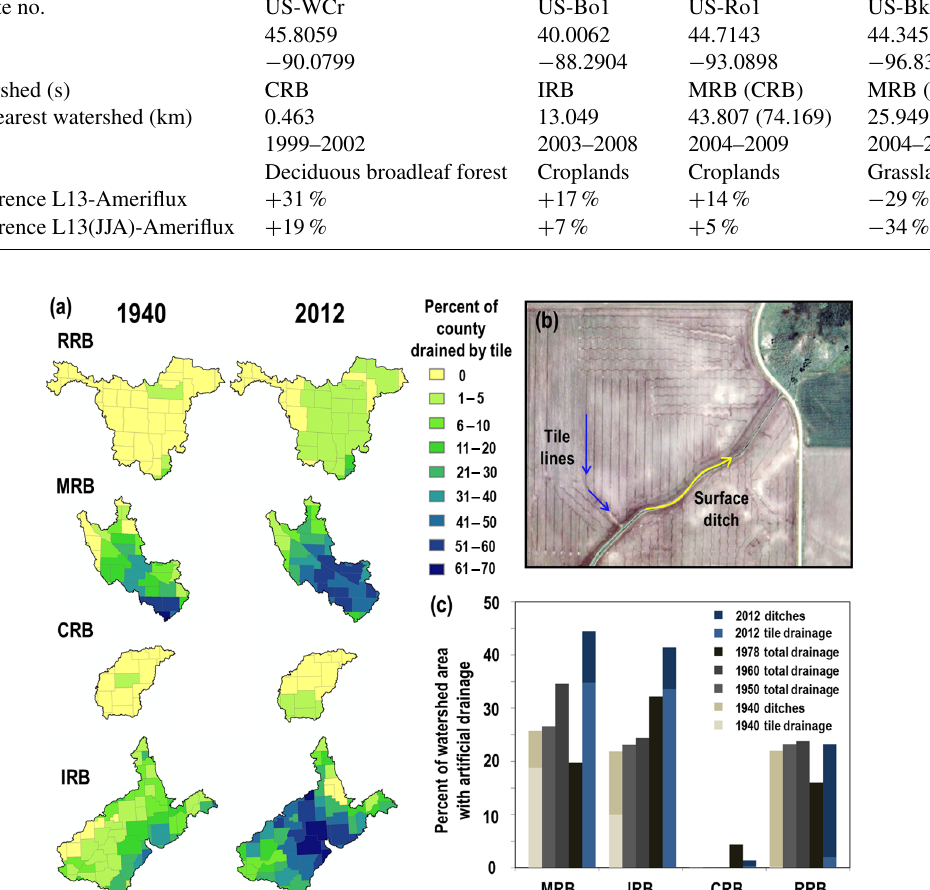
Figure 2. (a) Spatial distribution of tile drainage patterns in 1940 and 2012 for each of the four study basins: Red River of the North basin (RRB), Minnesota River basin (MRB), Chippewa River basin (CRB), and Illinois River basin (IRB). (b) Image showing an example field pattern that combines subsurface tile lines with a surface ditch. (c) Percentage of the total watershed area with artificial drainage from 1940, 1950, 1960, 1978, and 2012 drainage census data. The magnitude of each bar indicates total drainage (ditches and tiles), and 1940 and 2012 bars are broken proportionally into drainage by ditches and